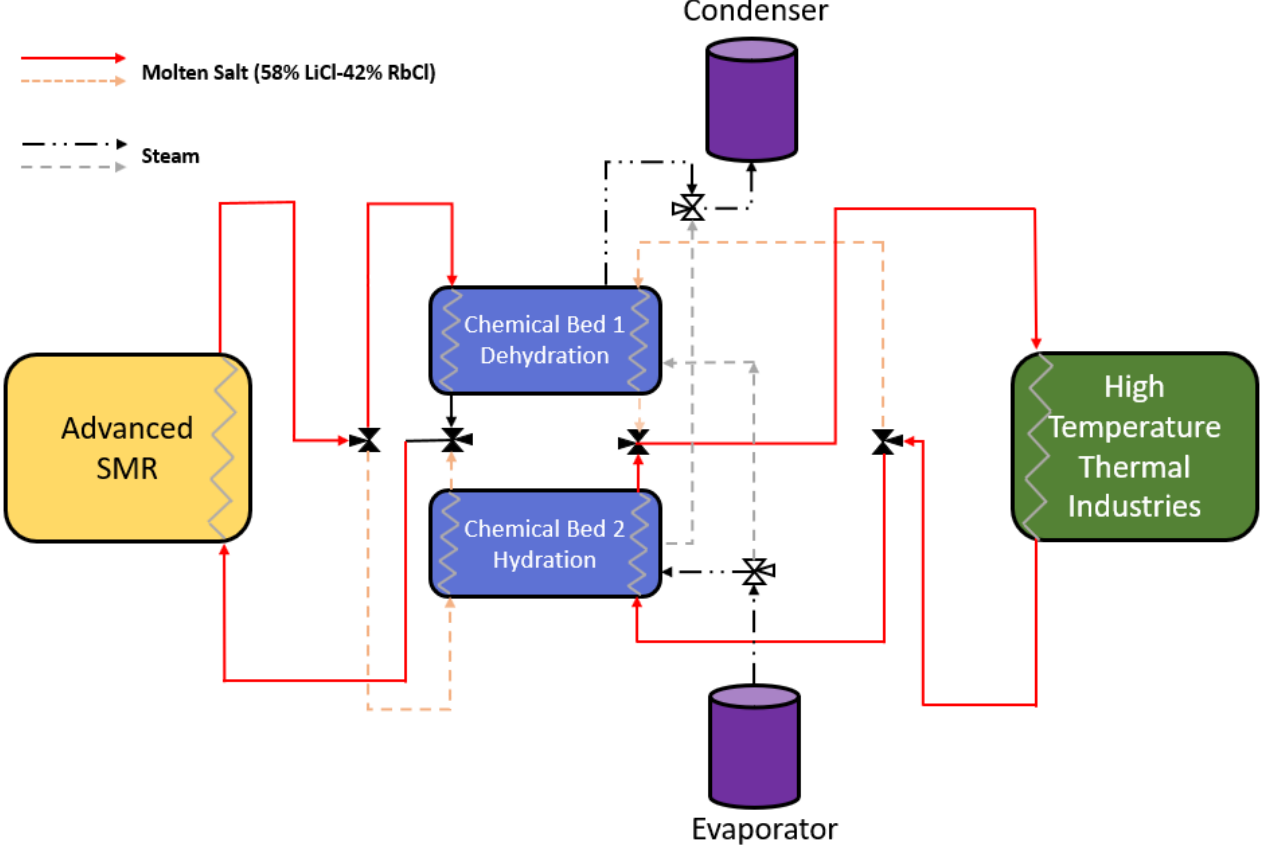
Figure 5. Schematic of ChHP coupled with SMR system .